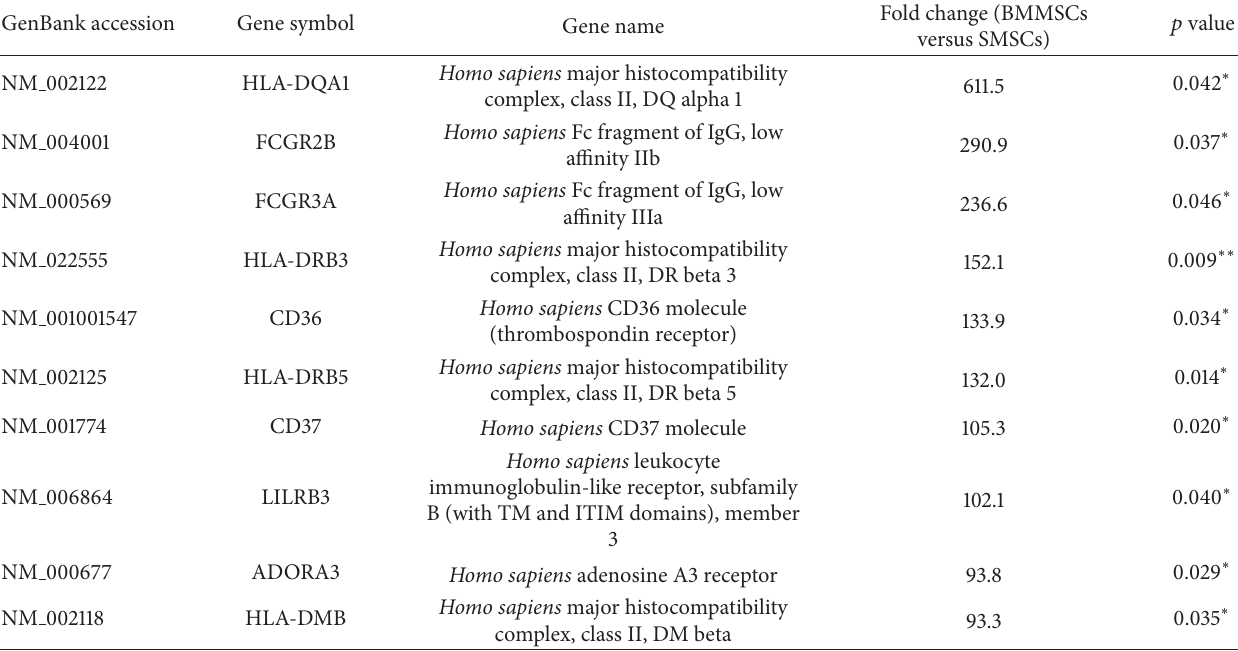
Table 3: Top ten genes with significantly differential expression involved in immune system process and regulation of immune system process of bone marrow mesenchymal stem cells (BMMSCs) and skin mesenchymal stem cells